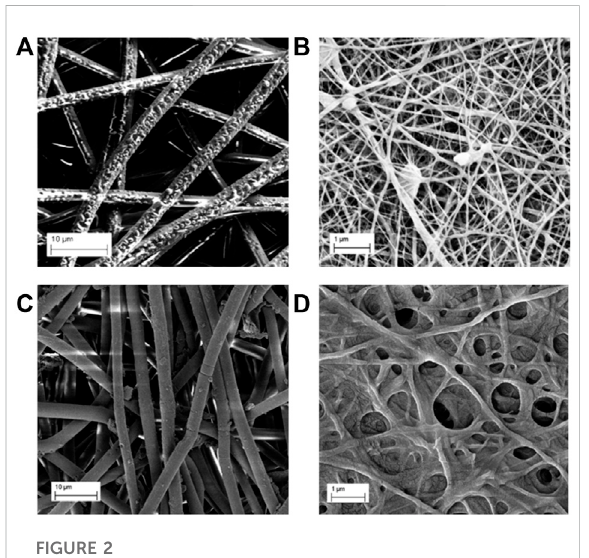
FIGURE 2 SEM images before immersion of (A) PLLA-Ag, (B) PLLA- AgHEC, and after 24 h of immersion in synthetic sweat of (C) PLLA-Ag and (D)